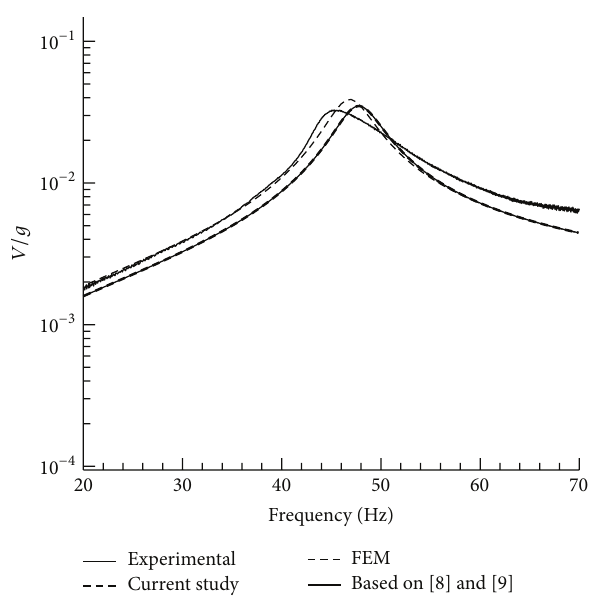
Figure 5: Output voltage/input acceleration versus frequency.